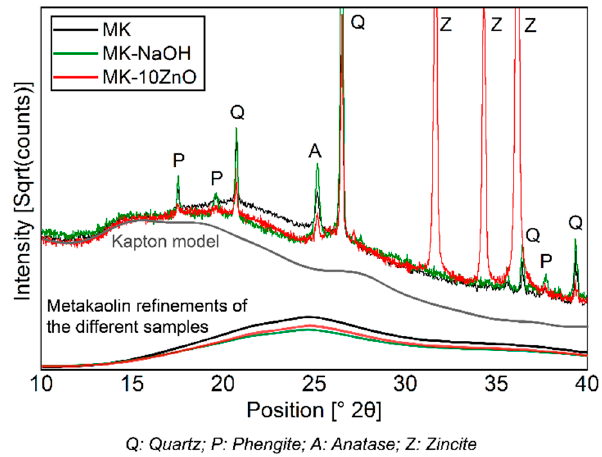
Figure 7. Comparison of di ff ractograms of MK-NaOH and a MK sample mixed with 10 wt.% ZnO as internal standard. The scattering contribution to the di ff ractogram of MK Am of the di ff erent samples and of the Kapton model is shown.